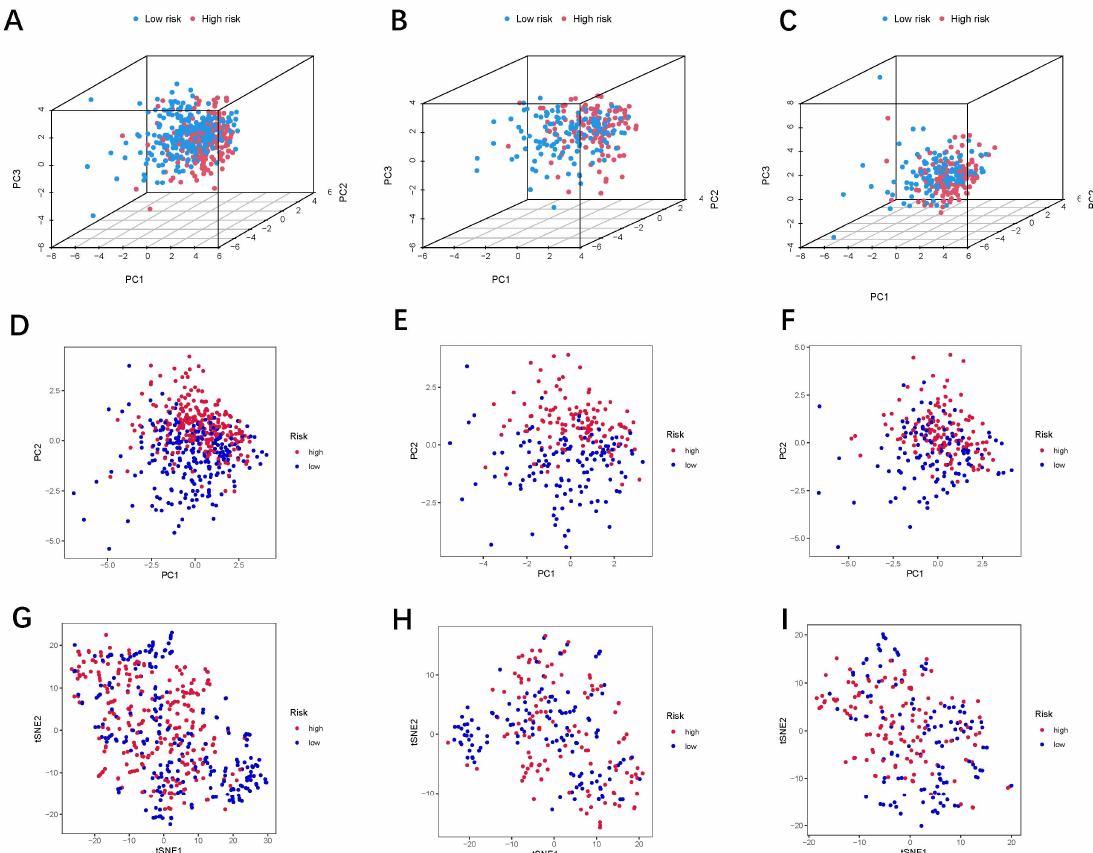
Figure 4. The PCA and t-SNE plot analysis between the low-risk and high-risk groups, based on the 24 oxidative lipid metabolism-related lncRNAs expression profiles. ( A – C ) PCA-3D plot analysis for all patients, train, and test groups. ( D – F ) PCA plot analysis for all patients, train, and test groups. ( G – I ): tSNE plot analysis for all patients, train and test groups.